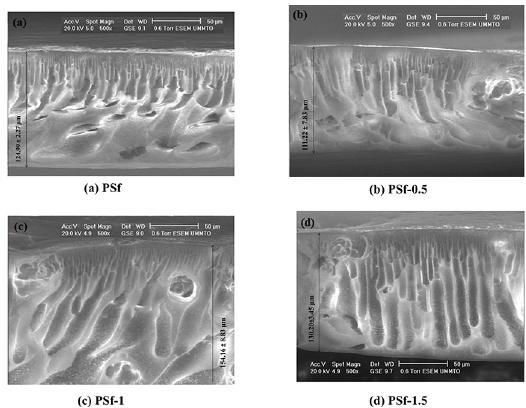
Figure 7: The FTIR-ATR spectra of the membranes: (a) 4000-450 cm -1 , (b) 4000-2250 cm -1 et (c) 2250-450 cm -1 . at 1242.83 cm -1 is assigned to the ether C-O-C stretch of